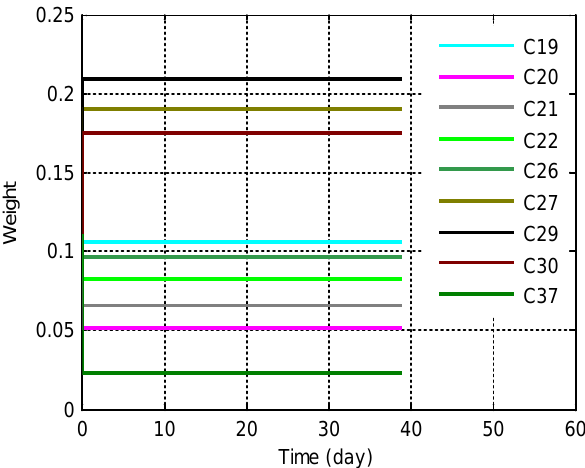
Figure 5. Weights of the clock ensemble (1 March–31 March 2019).